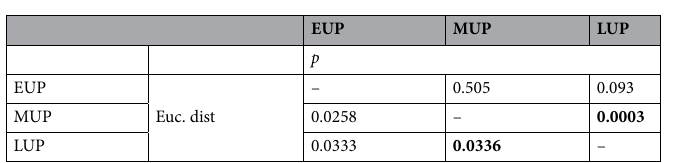
Table 3. Euclidean distances between the group averages calculated from the 15 first PCs. P-values of pairwise sample differences based on permutation